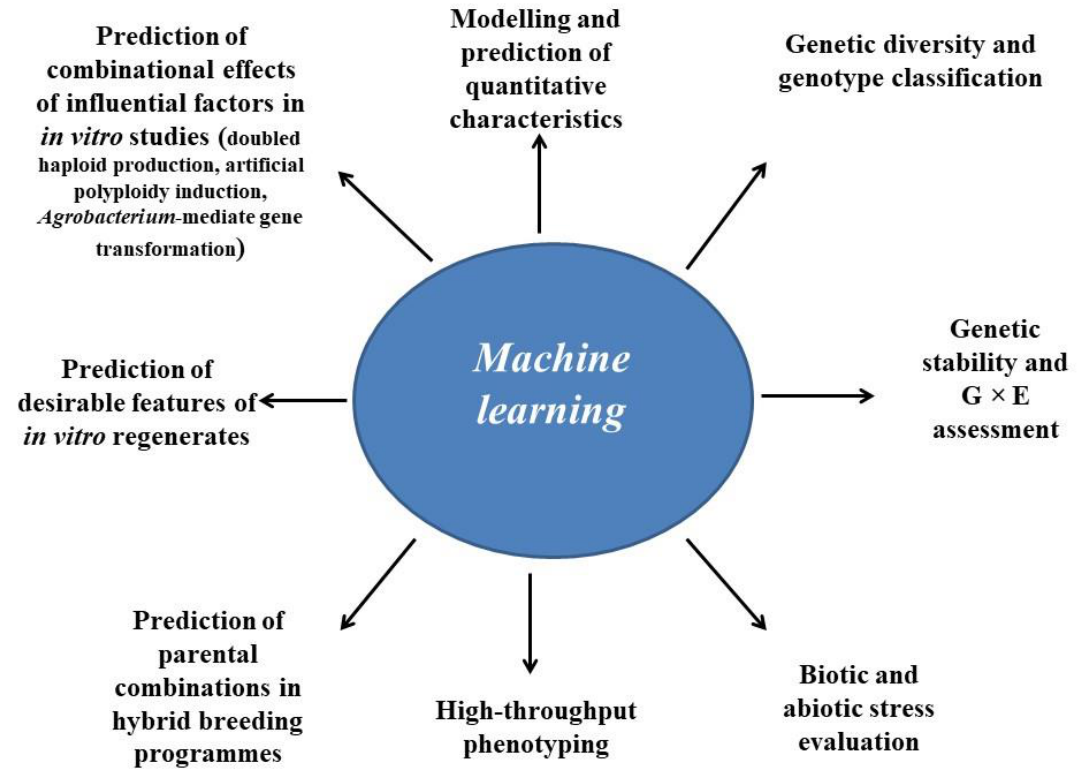
Figure 2. Potential applications of machine learning techniques in classical and modern plant breeding. Some recently applied nonlinear machine learning models in both classical and in vitro-based plant breeding studies are listed in Table